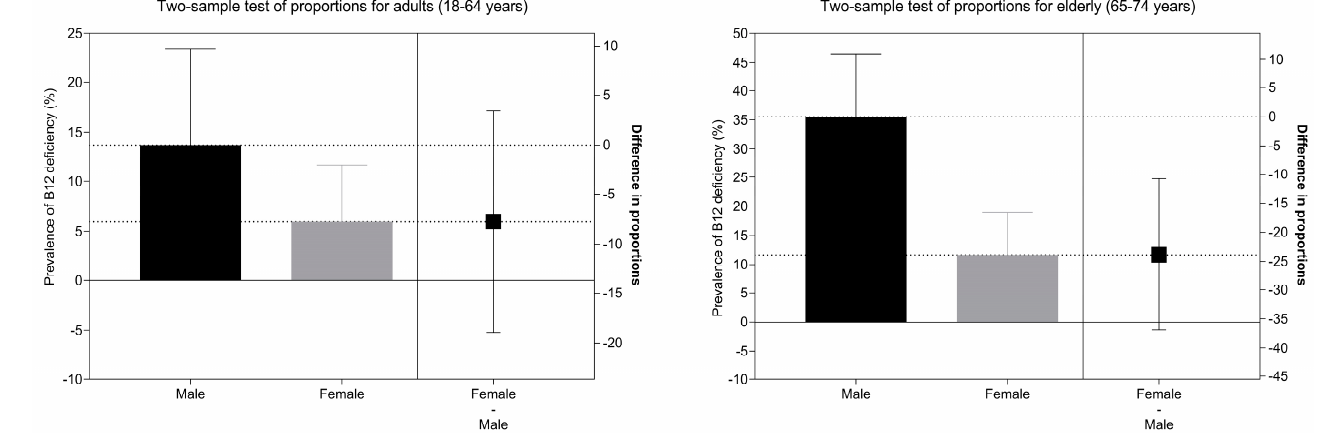
Figure 5. Analysis of differences in prevalence of vitamin B12 deficiency (serum vitamin B12 con- centration < 221 pmol/L and homocysteine > 15 µmol/L) between males and females in different age cohorts.